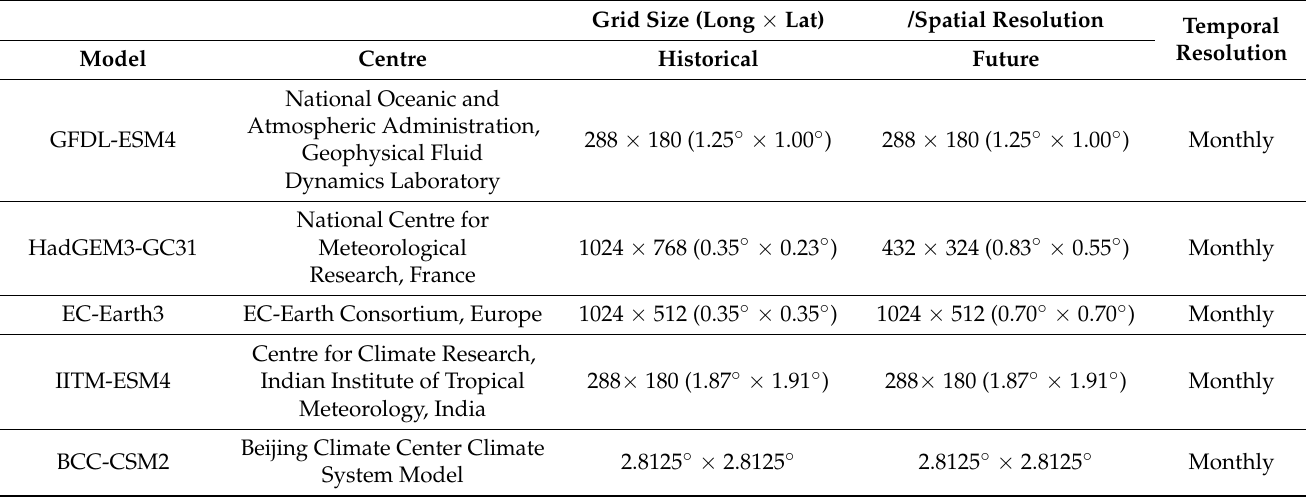
Table 2. Summary of the two Global Climate Model (GCM) from Coupled Model Intercomparison Project Phase 6 (CMIP6).